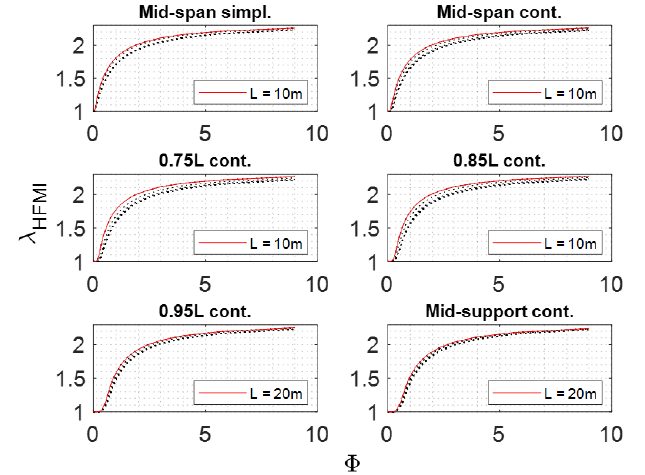
Figure 2. The generated Φ – λ HFMI curves categorized by position, adapted from [12], highest curves are depicted in red color, and dashed curve corresponds to different lengths.